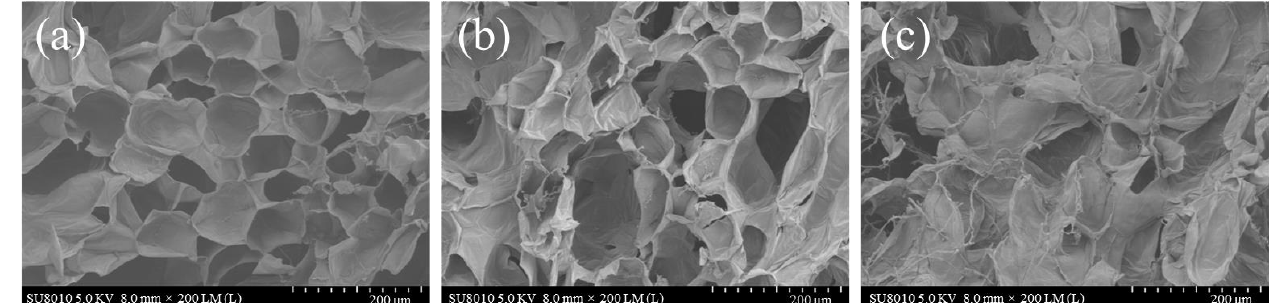
Figure 2. Scanning electron microscopy (SEM) of infected winter jujubes on ( a ) Day 0, ( b ) Day 2 and ( c ) Day 5 during the storage at 20 °C.